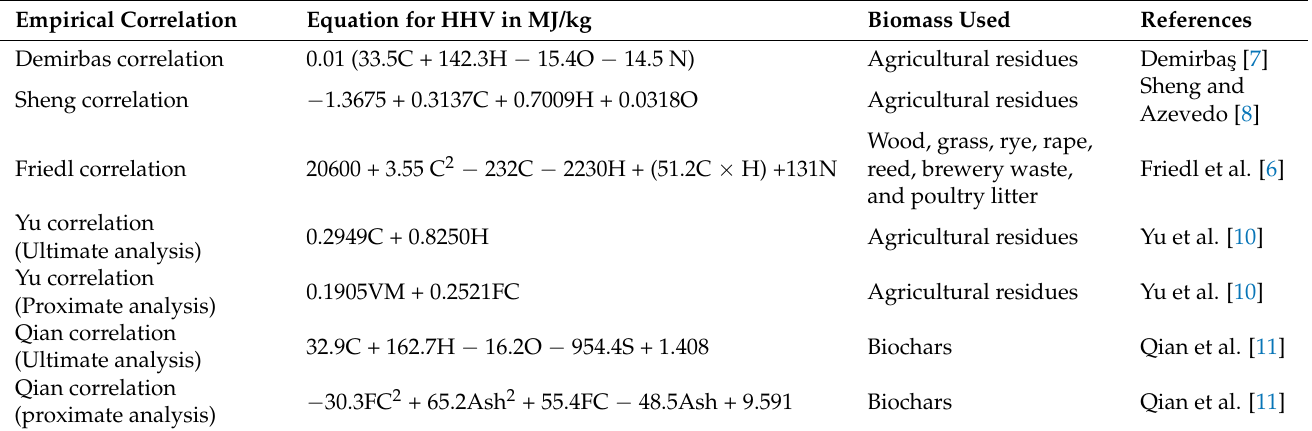
Table 1. Overview of different empirical correlations compared with ML